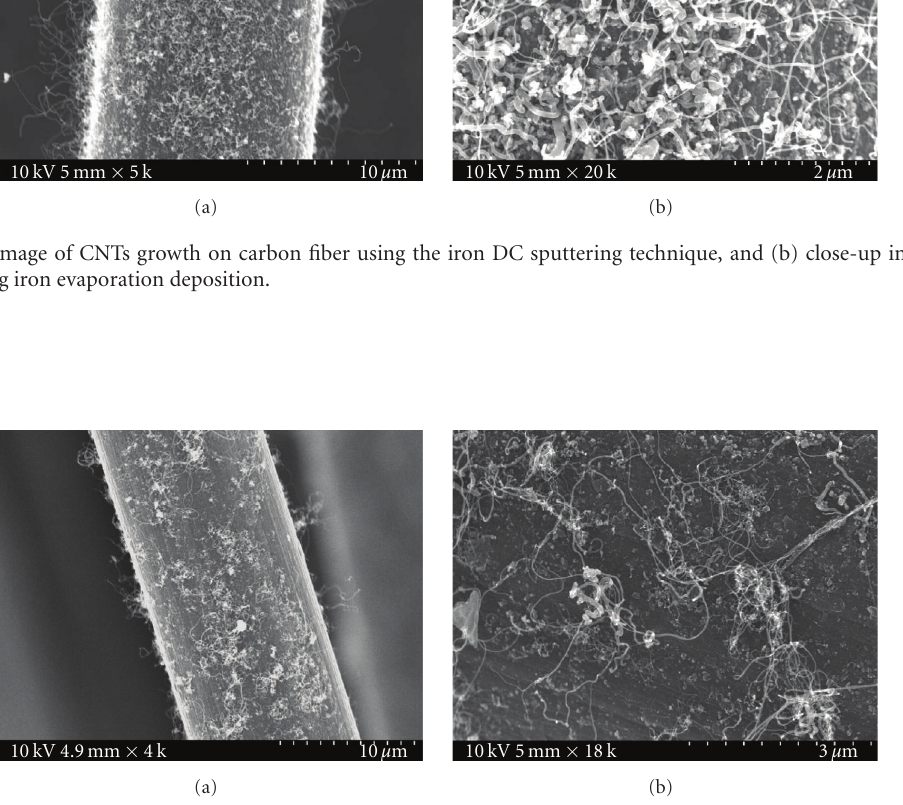
Figure 8: (a) SEM image of CNTs growth on carbon fiber using the electrochemical deposition of iron catalyst and (b) close up image of CNTs grown using electrochemical